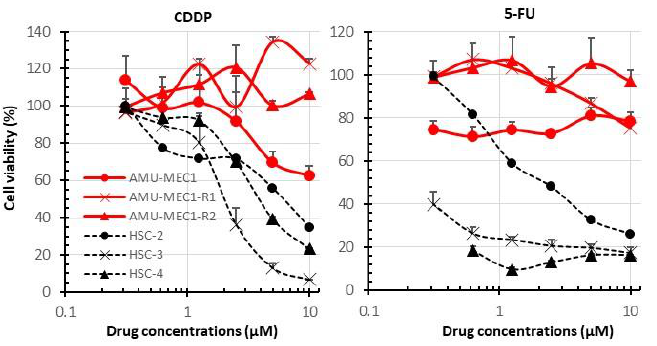
Figure 5. A comparison of the drug susceptibilities of MEC and OSCC cell lines. The susceptibility of each cell to CDDP ( left ) and 5-FU ( right ). The red and black dotted lines indicate MEC and OSCC cell lines, respectively. The mean and SD of triplicate measurements are shown.